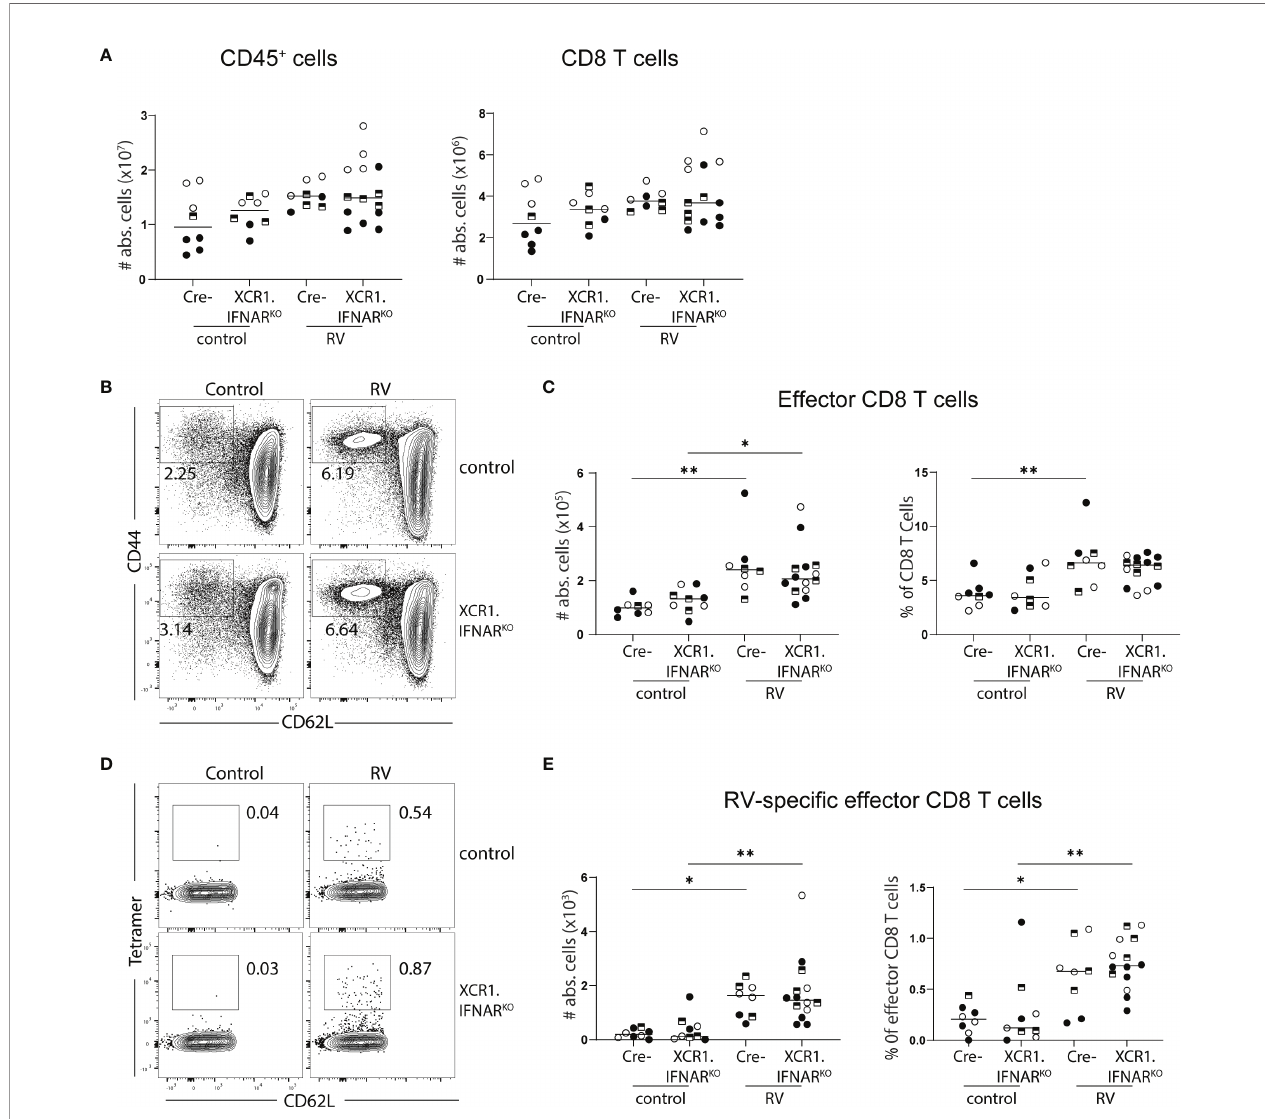
FIGURE 3 | Interferon signalling via cDC1 is dispensable for the generation of the RV-speci fi c CD8 T cell response. XCR1.IFNAR KO and control mice were infected with RV. (A-E) MLN cells isolated from uninfected control and RV infected WT and XCR1.IFNAR KO mice seven days post oral infection. (A) Total number of CD45 + cells and CD8 T cells (CD45 + CD3 + CD4 - CD8 a + ). (B) Representative FACS plot of effector CD8 T cells (CD62L - CD44 + ) pre-gated on CD45 + CD3 + CD4 - CD8 a + cells. (C) Absolute cell numbers and frequency of effector CD8 T cells (CD62L - CD44 + ). (D) Representative FACS plot of RV-speci fi c effector CD8 T cells (CD44 + CD62L - Tet + ). (E) Absolute cell numbers and frequency of RV-speci fi c effector CD8 T cells. Each data point represents one mouse from a total of three different experiments, indicated by the different symbols. Ordinary one-way ANOVA with Tukey´s multiple comparison test was performed for statistical analysis. *p < 0.05, **p <